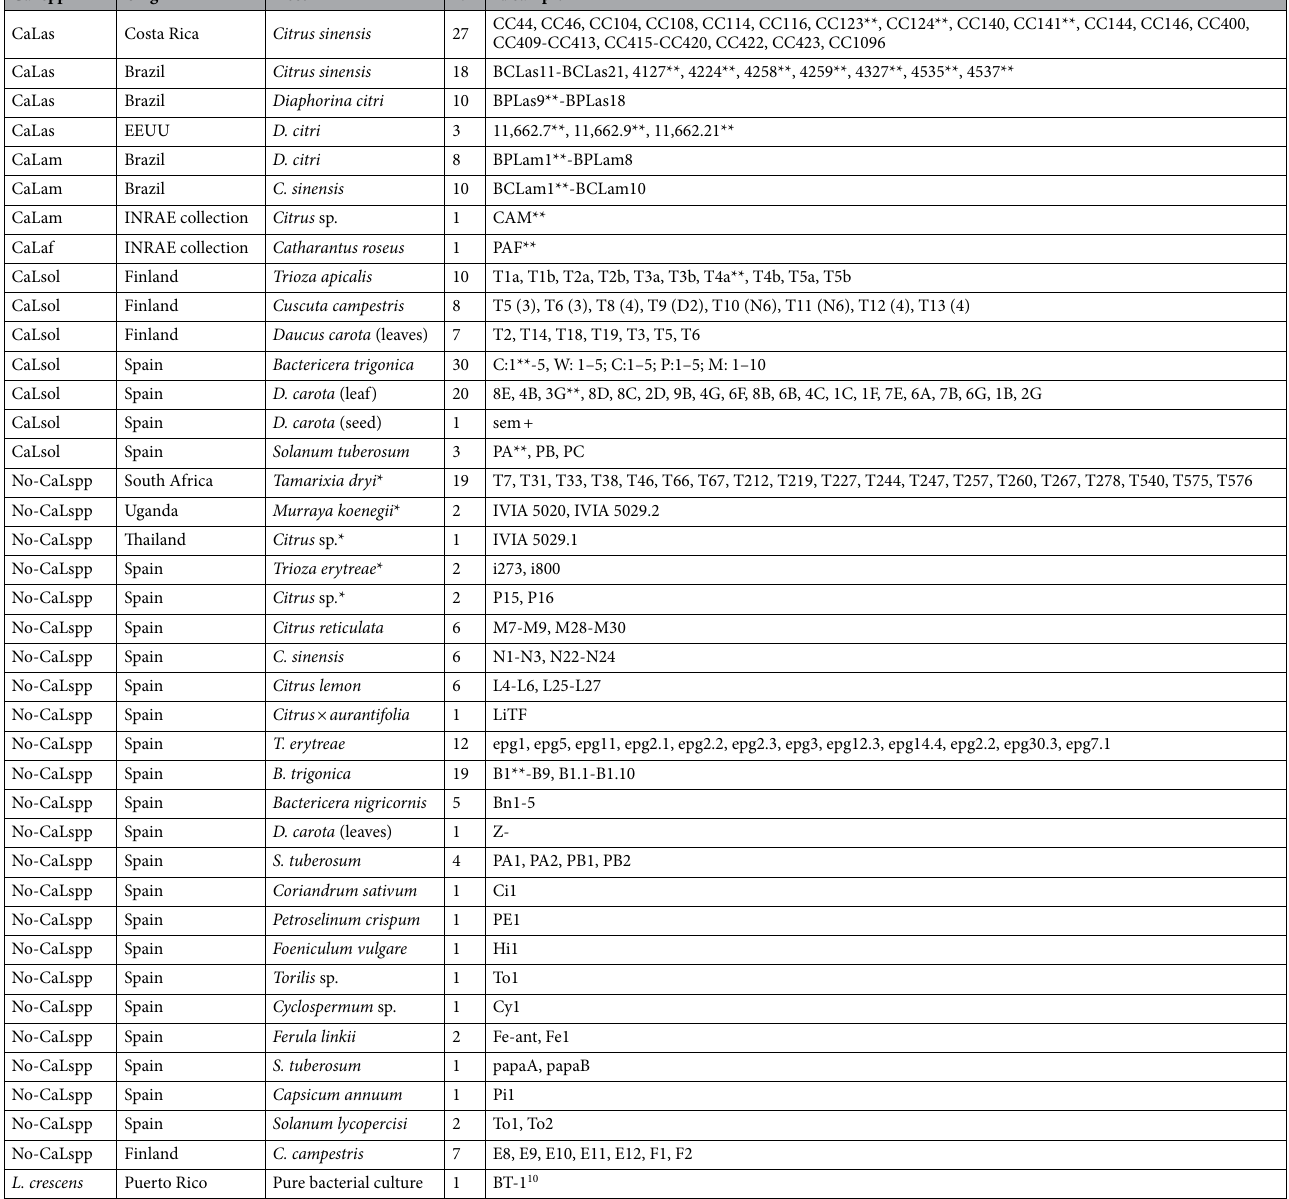
Table 3. Plant and insect samples used in the present study. *Samples previously described as undesired amplifications by Morán et al . 47 . **Samples selected for partial Sanger sequencing of the rpoB gene. 1 Detection of CaLspp were done by qPCR following the protocols designed by Li et al . 44,54 ; Teresani et al . 25 ; Bertolini et al 46